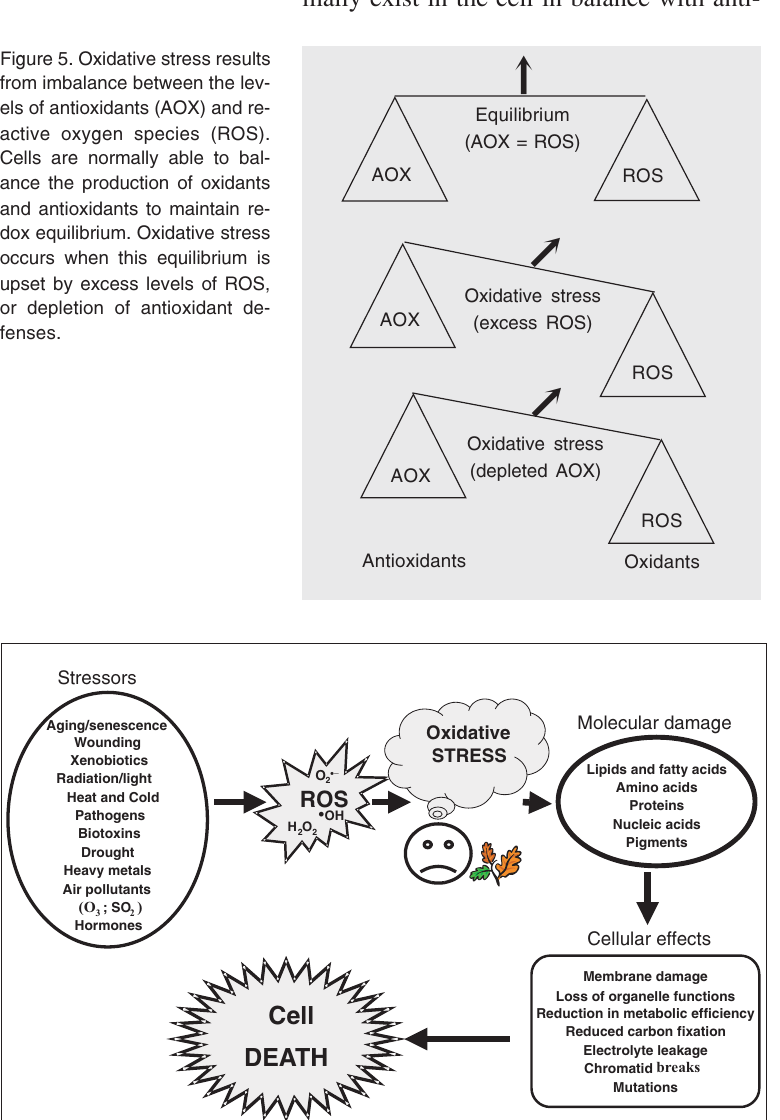
Figure 6. Scheme showing some of the initiators (stressors) of reactive oxygen species (ROS) and the biological consequences leading to a variety of physiological dysfunctions that can lead to cell